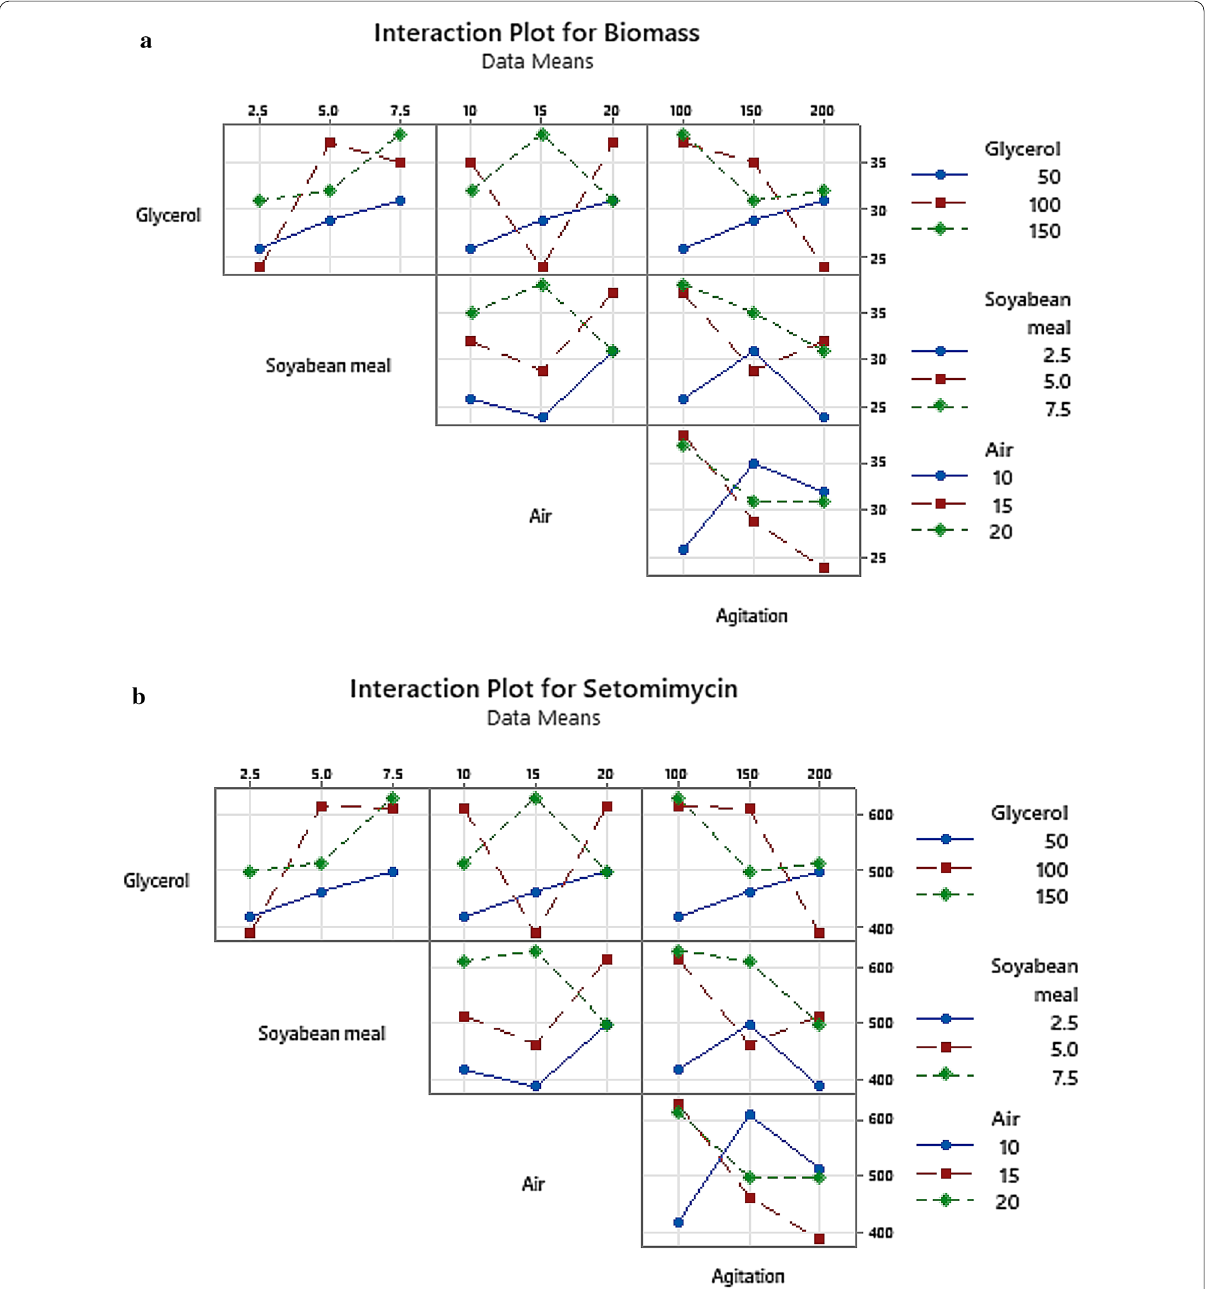
Fig.5 Interaction plots of various factors on ( a ) Biomass (DCW) ( b ) setomimycin production by Streptomyces sp. RA-WS2 and Contour plots for ( c ) Biomass (DCW) ( d ) Setomimycin production by Streptomyces sp.